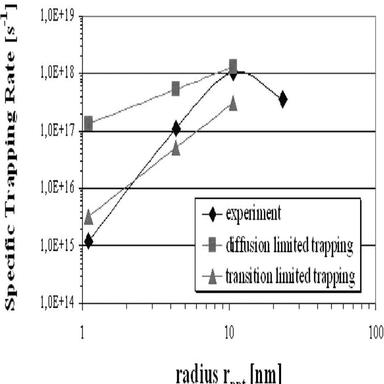
The experimental values of the specific trapping rate μppt (diamond line), deduced from the simple trapping model by (9) using the data from 2, as a function of precipitate radius rppt. The experimental curve is compared with theoretical curves for diffusion 10) and transition limited trapping 11). The line for the diffusion limited trapping in pure Cu is square line, the line related to transition limited trapping is triangular line and the experimental depen